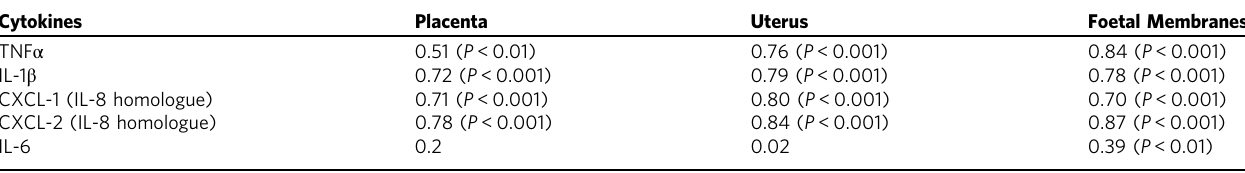
Values are (Spearman ’ s R 2 ) with signi fi cance values of correlation within